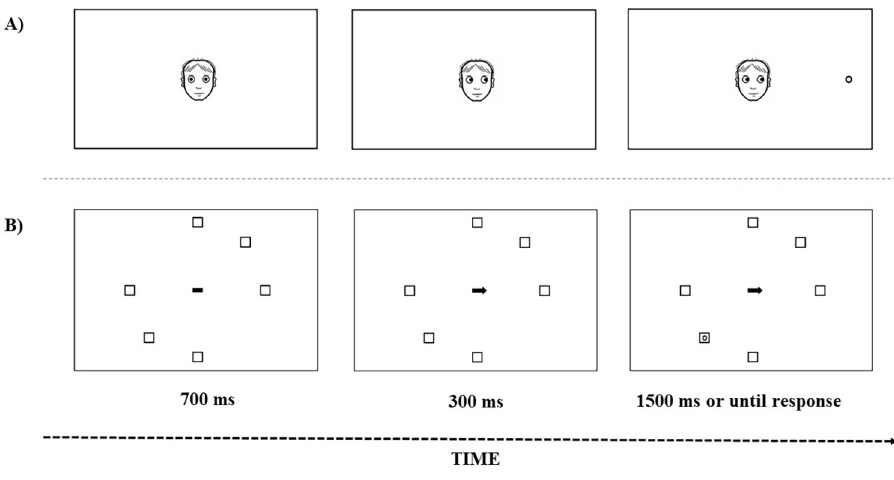
Fig 4. Schematic view of a trial sequence for both the gaze cue and the arrow cue conditions of Experiment 2. The example represents: A) gaze/placeholder-absent/same-location/same-group condition, B) arrow/placeholder-present/ opposite-group